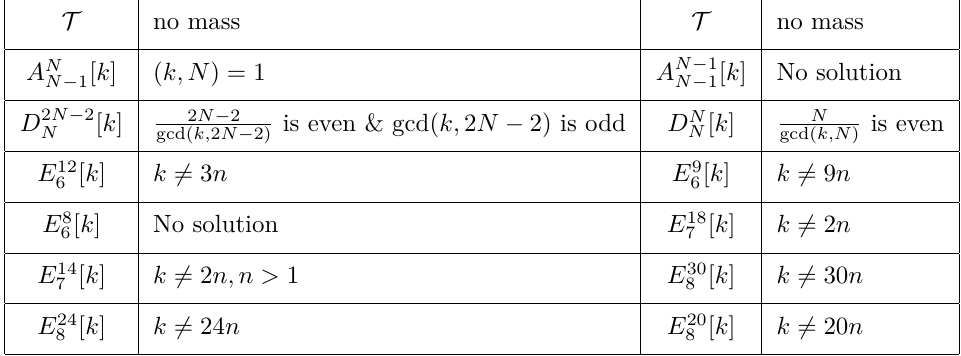
Table 5 . Constraint on k so that irregular singularity denoted by J b [ k ] has no mass deformation. j with twist